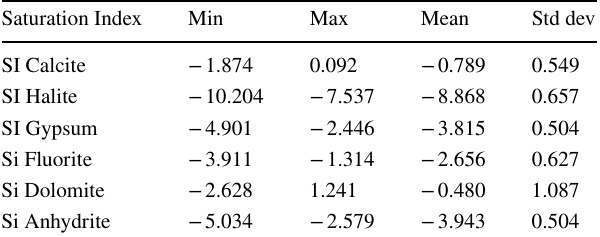
Table 6 Summary of the mineral saturation index statistics in the study area